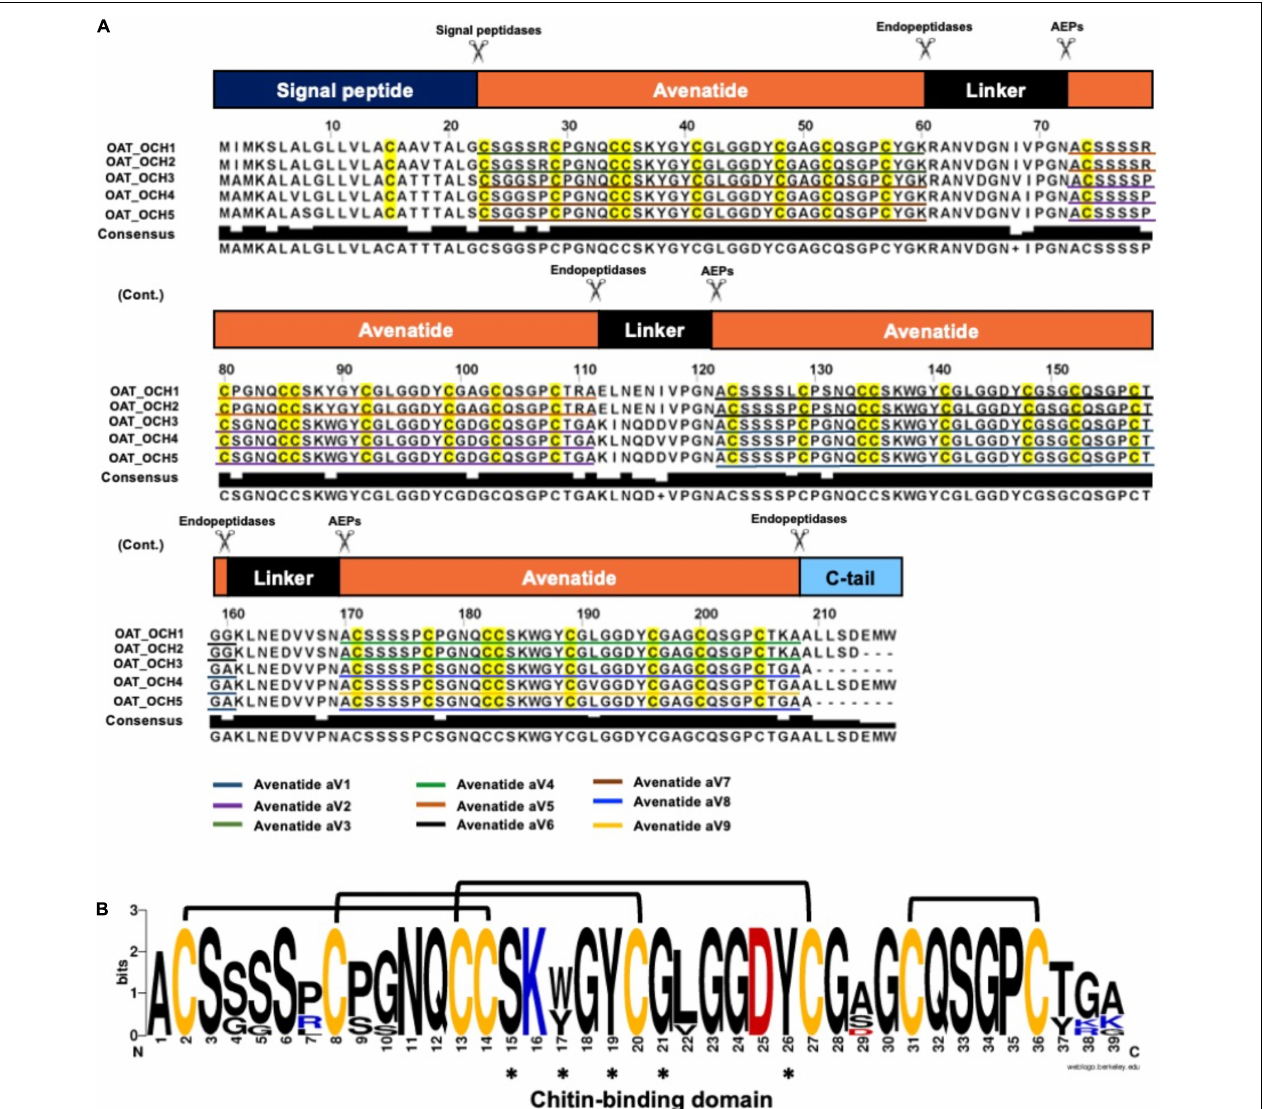
FIGURE 2 | Biosynthetic precursors and sequence comparison of avenatides. (A) Alignment of avenatide precursor sequences. Avenatide precursors contain an N-terminal signal peptide, four tandem repeating mature hev-peptide domains, and a C-terminal tail. The signal peptide is cleaved by signal peptidase, whereas the C-terminal domain and linkers are likely cleaved by an asparaginyl endopeptidase at the conserved Asn-Ala dipeptide motif to release the mature avenatide domain with Ala as the N-terminal amino acid in avenatides. (B) Consensus sequence of avenatides. The disulfide connectivity is based on the NMR-determined structure shown in Figure 3 and amino acid residues contributing to the conserved chitin-binding sites are indicated by asterisks.